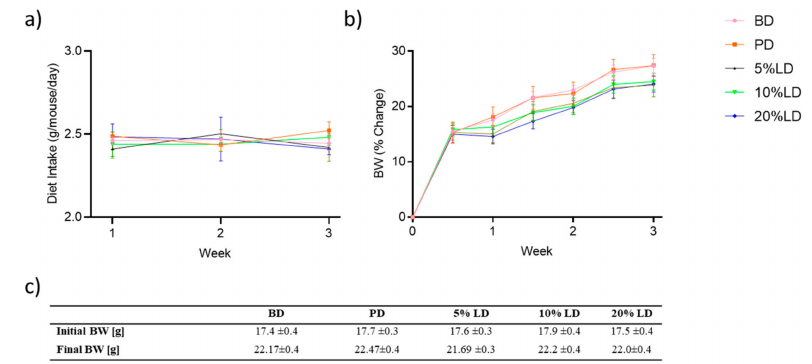
Figure 1. The e ff ect of lentil supplementation on body weight and diet intake. ( a ) Average diet intake (g / mouse / day), ( b ) body weight (BW) change (%), and ( c ) initial and final BW (g) of C57Bl / 6 mice receiving basal diet (BD) or diets supplemented with pectin (PD), or 5, 10, 20% lentils (LD). Values are mean ± SEM; n = 12 / group; p >